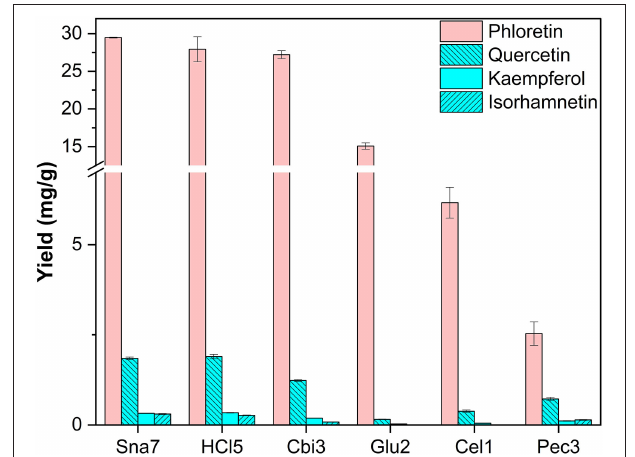
FIGURE 8 | Aglycone yields (mg/g) from leaf extracts of M. × domestica . Enzymatic hydrolysis (25min): Sna7: 5mg snailase (pH 5.5, 37 ◦ C); Cbi3: 5U cellobiase (pH 4.5, 37 ◦ C); Glu2: 20U β -glucosidase (pH 5.0, 37 ◦ C); Cel1: 20U cellulase (pH 5.5, 52 ◦ C); Pec3: 20U pectinase (pH 4.5, 40 ◦ C). Acidic